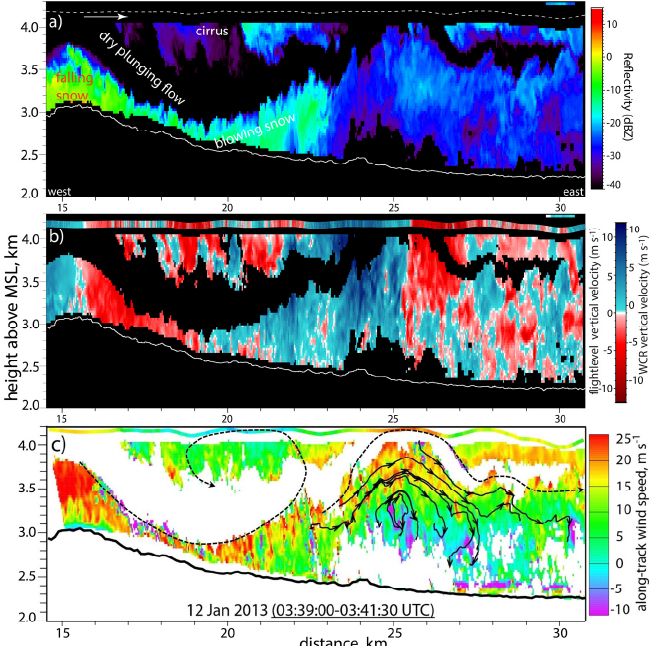
Figure 13. Zoomed-in view of the lee portion of the last WCR transect (distance matches with Figure 12d) highlighting the hydraulic jump and rotors. ( a ) Radar reflectivity; ( b ) hydrometeor vertical velocity; and ( c ) along-track wind speed with hydrometeor streamlines (solid lines) and schematically drawn counter-rotating vortices (dashed lines). The flight level is shown as a dashed line in ( a ), and flight-level vertical velocity and zonal wind speed are shown in ( b ) and ( c ), respectively.